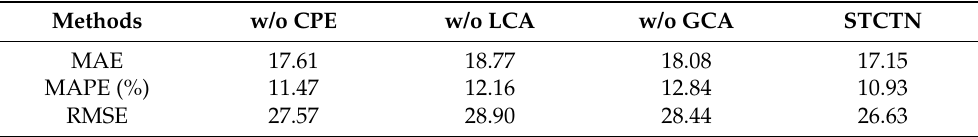
Table 4. Ablation study on PEMS08 dataset.